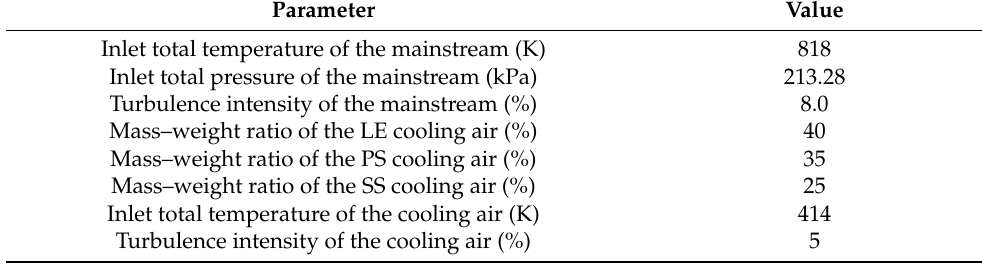
Table 3. Boundary conditions.